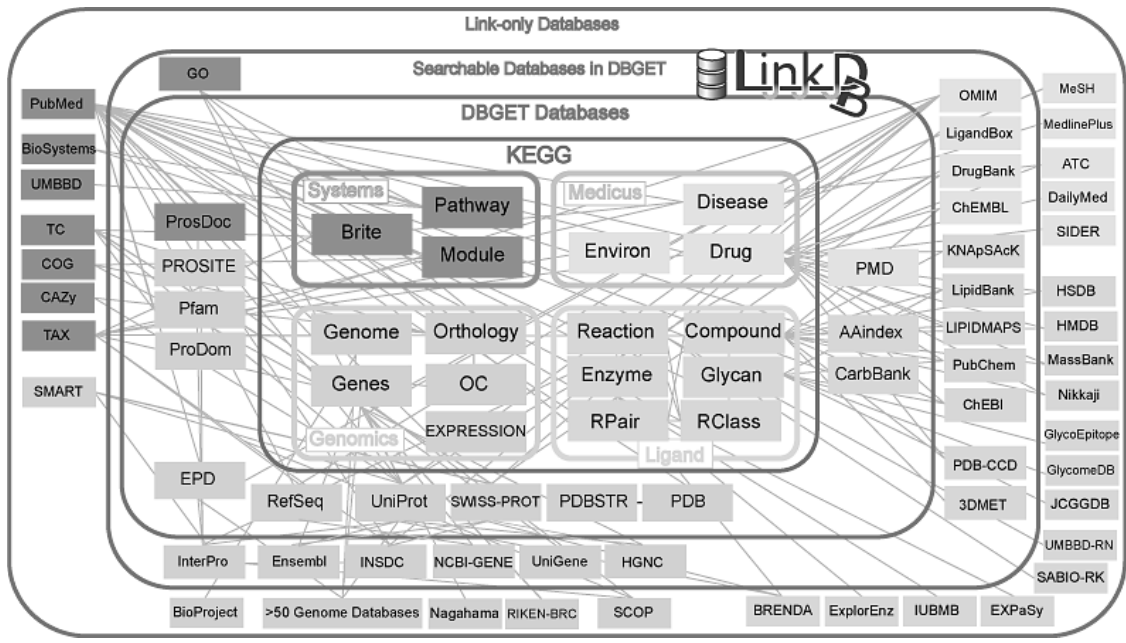
Figure 3. Example of database interconnection. DBGET materials (Japan).